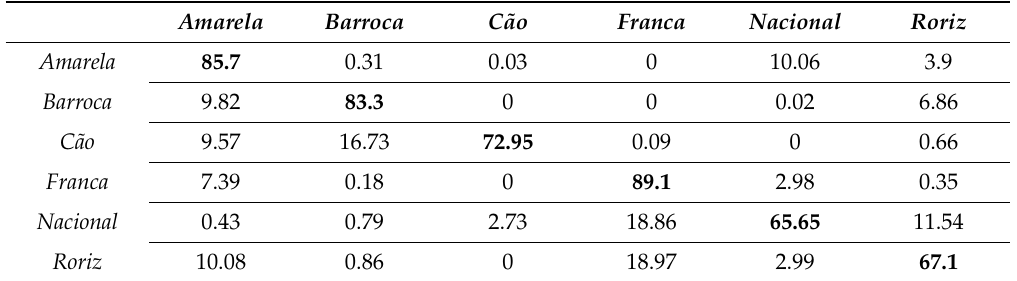
Table 7. Confusion matrix over the test set (in